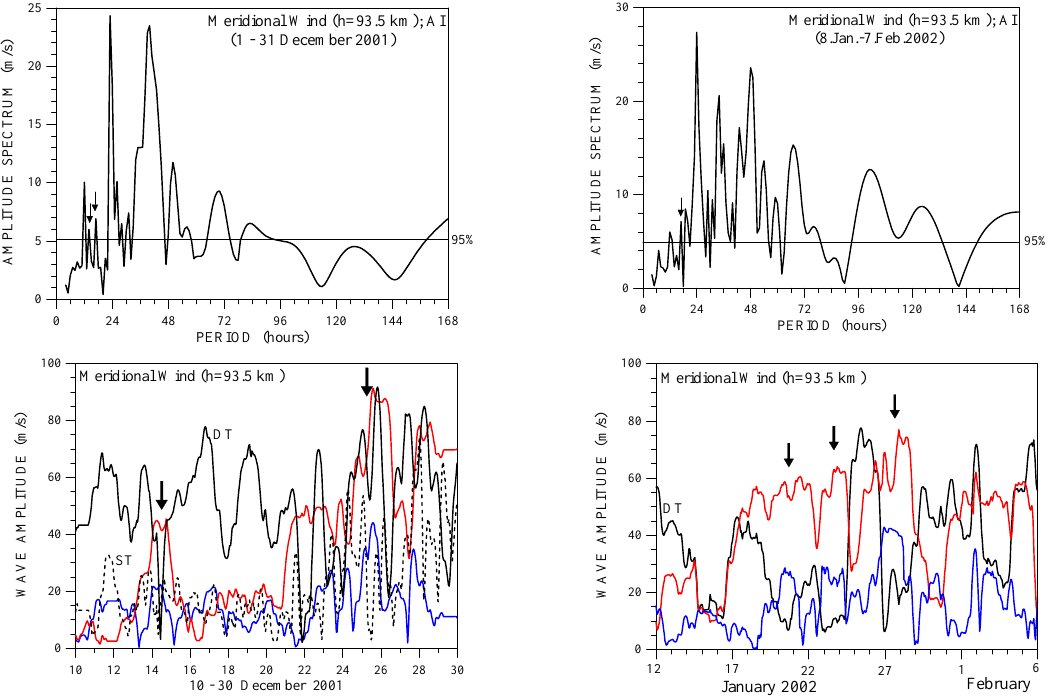
Fig. 14. Amplitude spectrum of the meridional wind observed from 1–31 December 2001 for altitude 93.5km. Marked by arrows peaks have periods respectively 14.5 and 17h (upper left plot). Variability of the amplitudes of the diurnal (black solid line) and semidiurnal (black dashed line) tides obtained by the best fit procedure and the amplitudes of the 40-h (red line) and 16-h (blue line) waves obtained by the complex demodulation method (bottom left plot). Amplitude spectrum of the meridional wind observed in 8 January–7 February 2002 for altitude 93.5km (upper right plot). Variability of the amplitudes of diurnal tide (black solid line), 48- (red line) and 16-h (blue line) waves obtained by the best fit procedure (bottom right